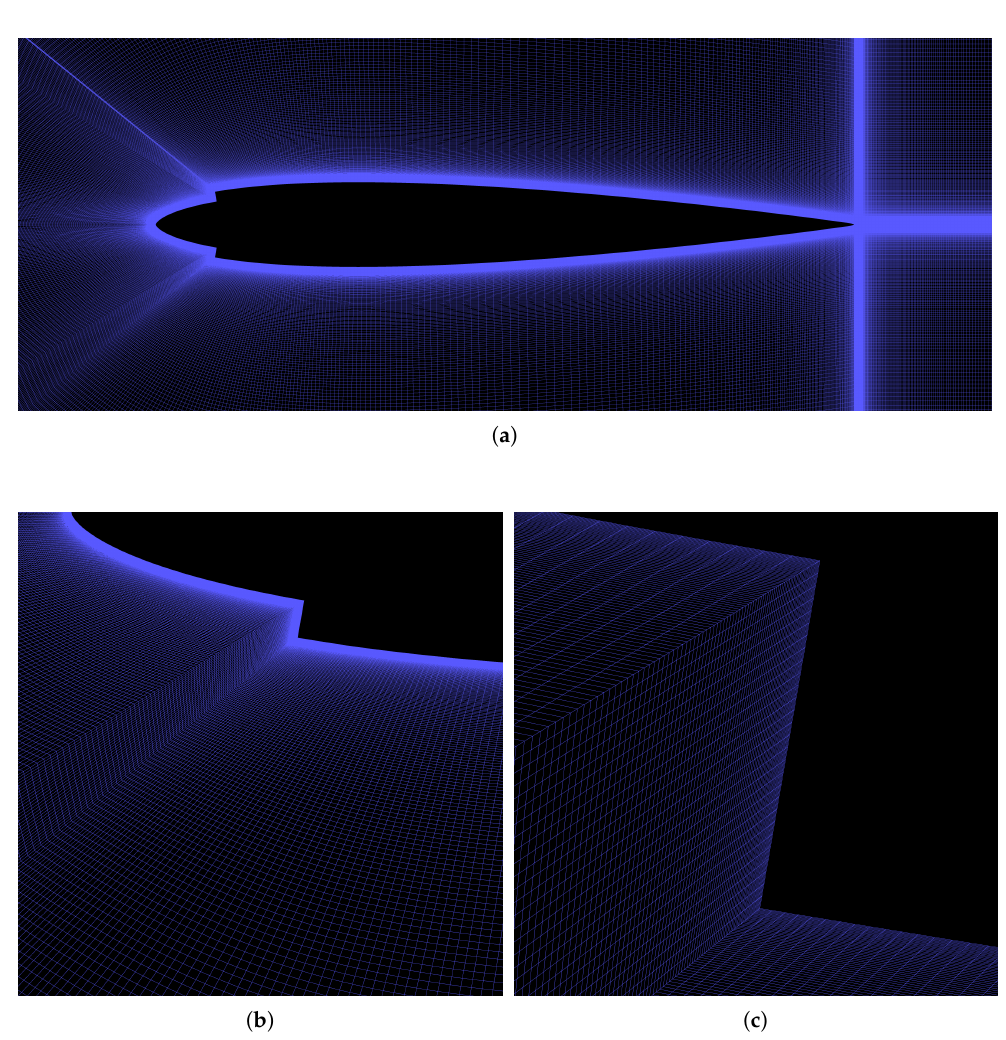
Figure 6. Mesh overview ( a ) and details ( b,c ). The figures refer to the fine grid of 500 k